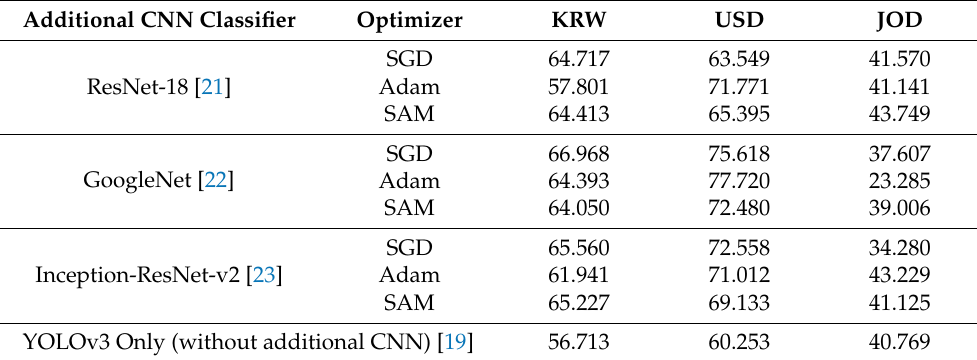
Table 3. Experimental results of training on EUR and testing on the other currency types using YOLOv3 and a single state-of-the-art CNN classifier. (Measure: mAP, unit: %).